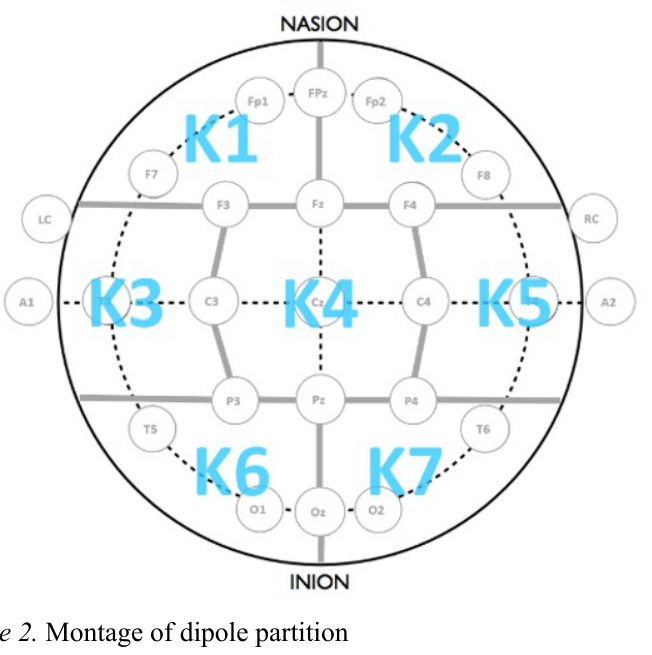
Figure 2. Montage of dipole partition